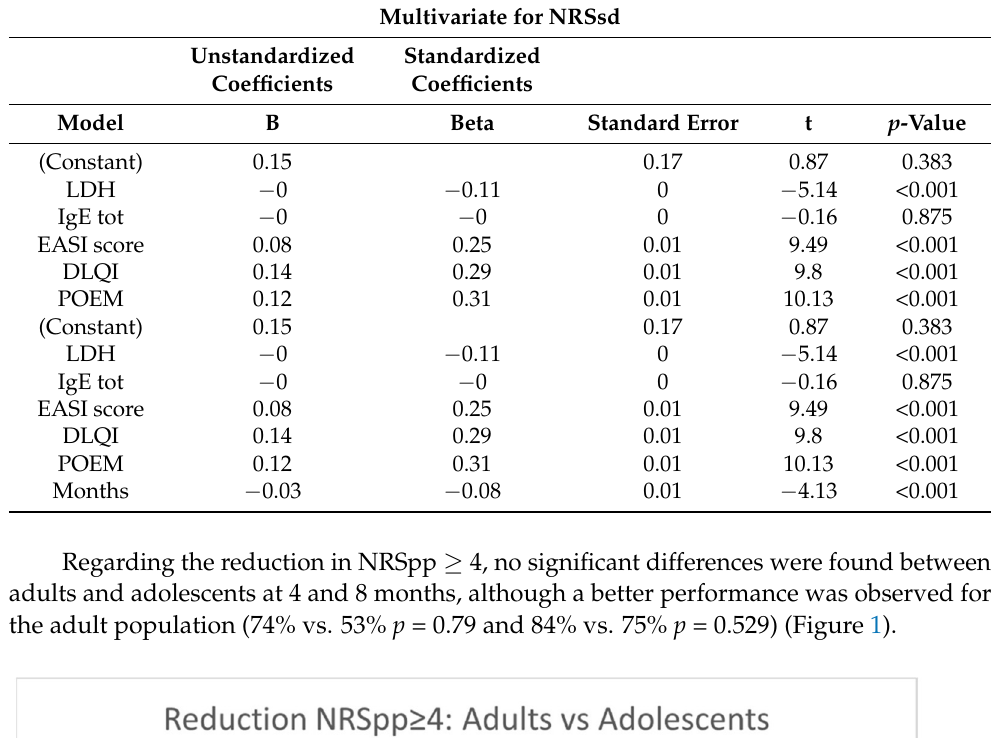
Table 6. Multivariate analysis for NRSsd with and without months of treatment.